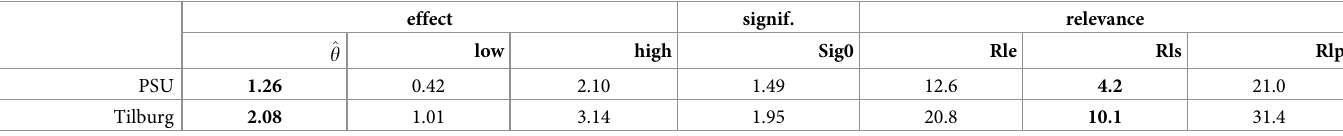
Table 5. Results for the second example. Relevance threshold 10% ℓ